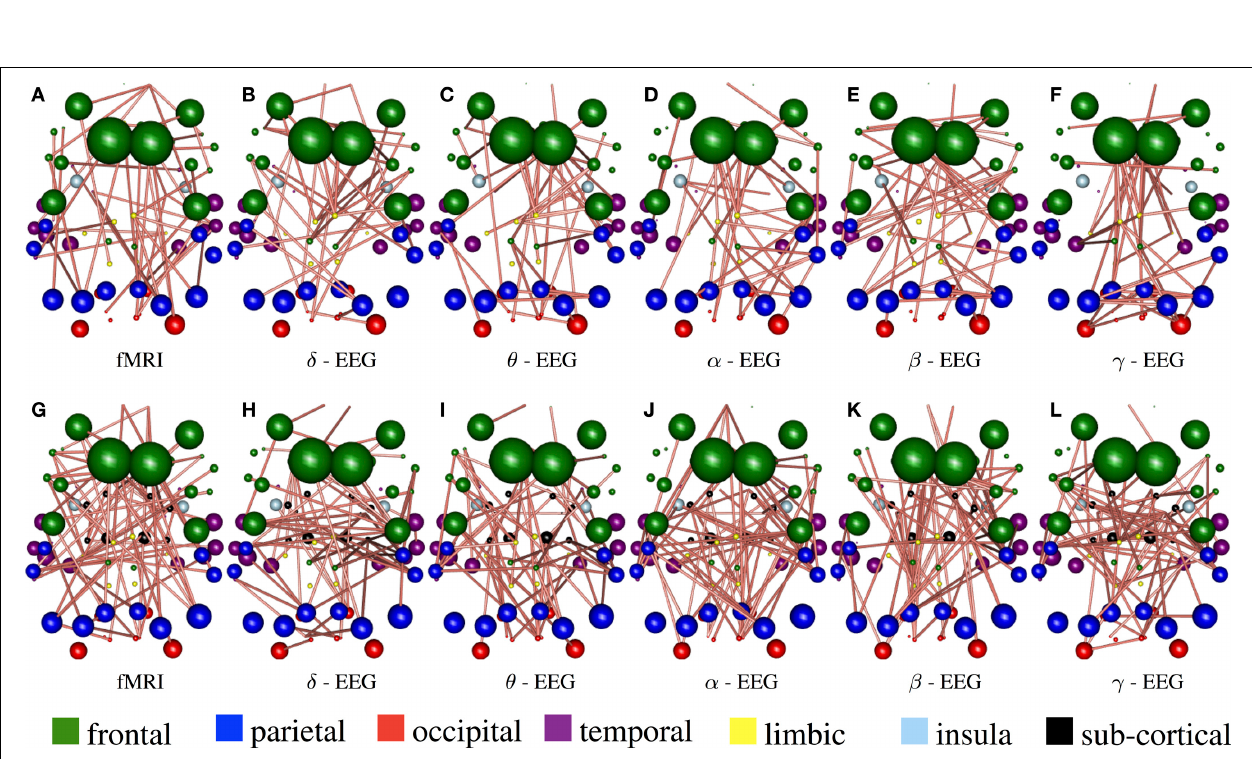
between the measured EEG and fMRI precision matrices across bands when we use only subcortical structures, only cortical structures and both cortical and subcortical structures. d AI has been normalized based on the line fit of the median values of the simulation data. This is approximately equivalent of dividing by the number of regions.